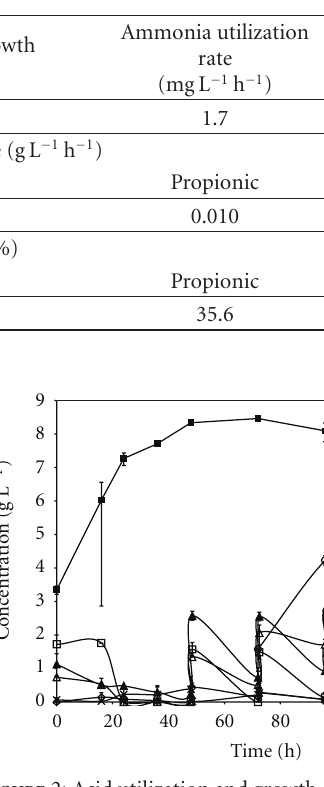
Table 3: Average growth and nutrient utilization rates of R . eutropha in CCS medium through 48h in shake flasks.